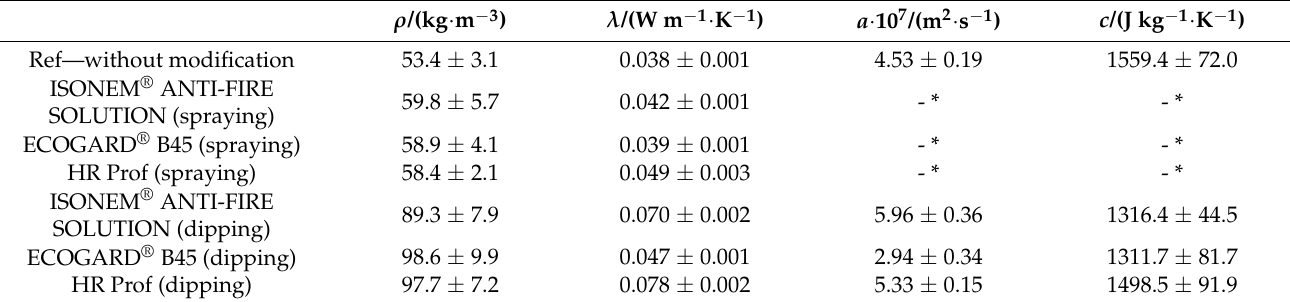
Table 1. Thermophysical properties of Senizol AT XX2 TL60 before and after modification with flame